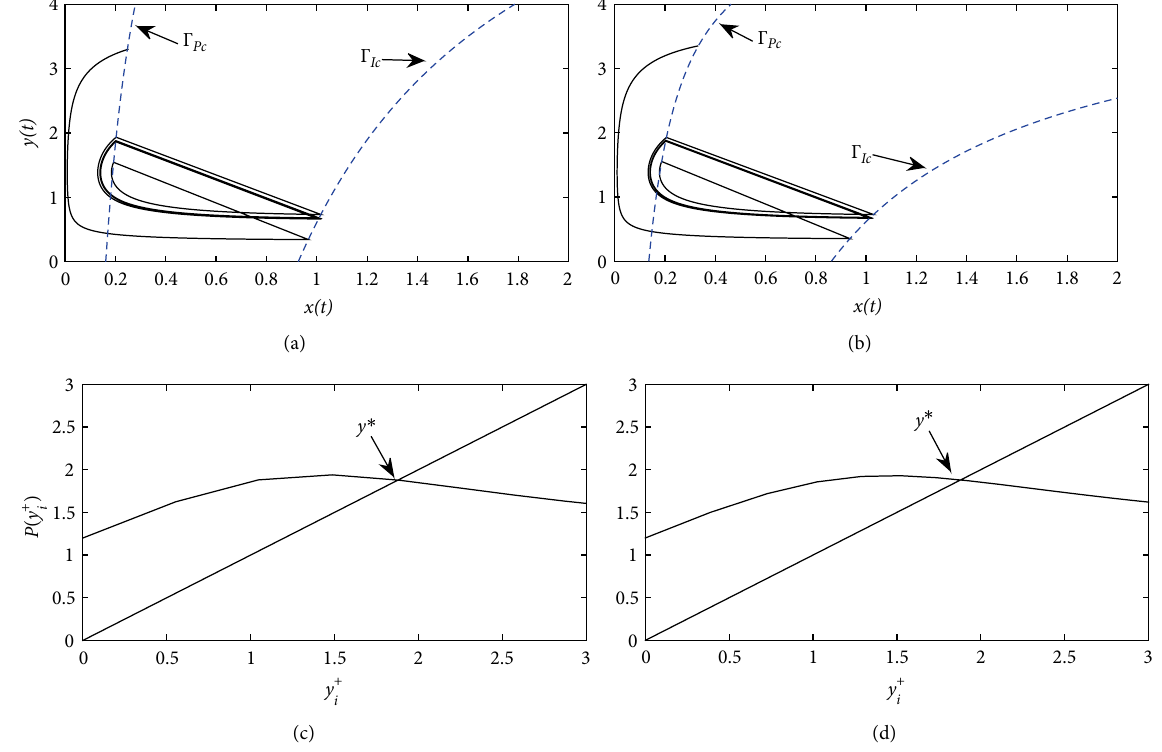
, , 푞 = 1.3 휆 = 0.52 , (d) 훽 = 0.2